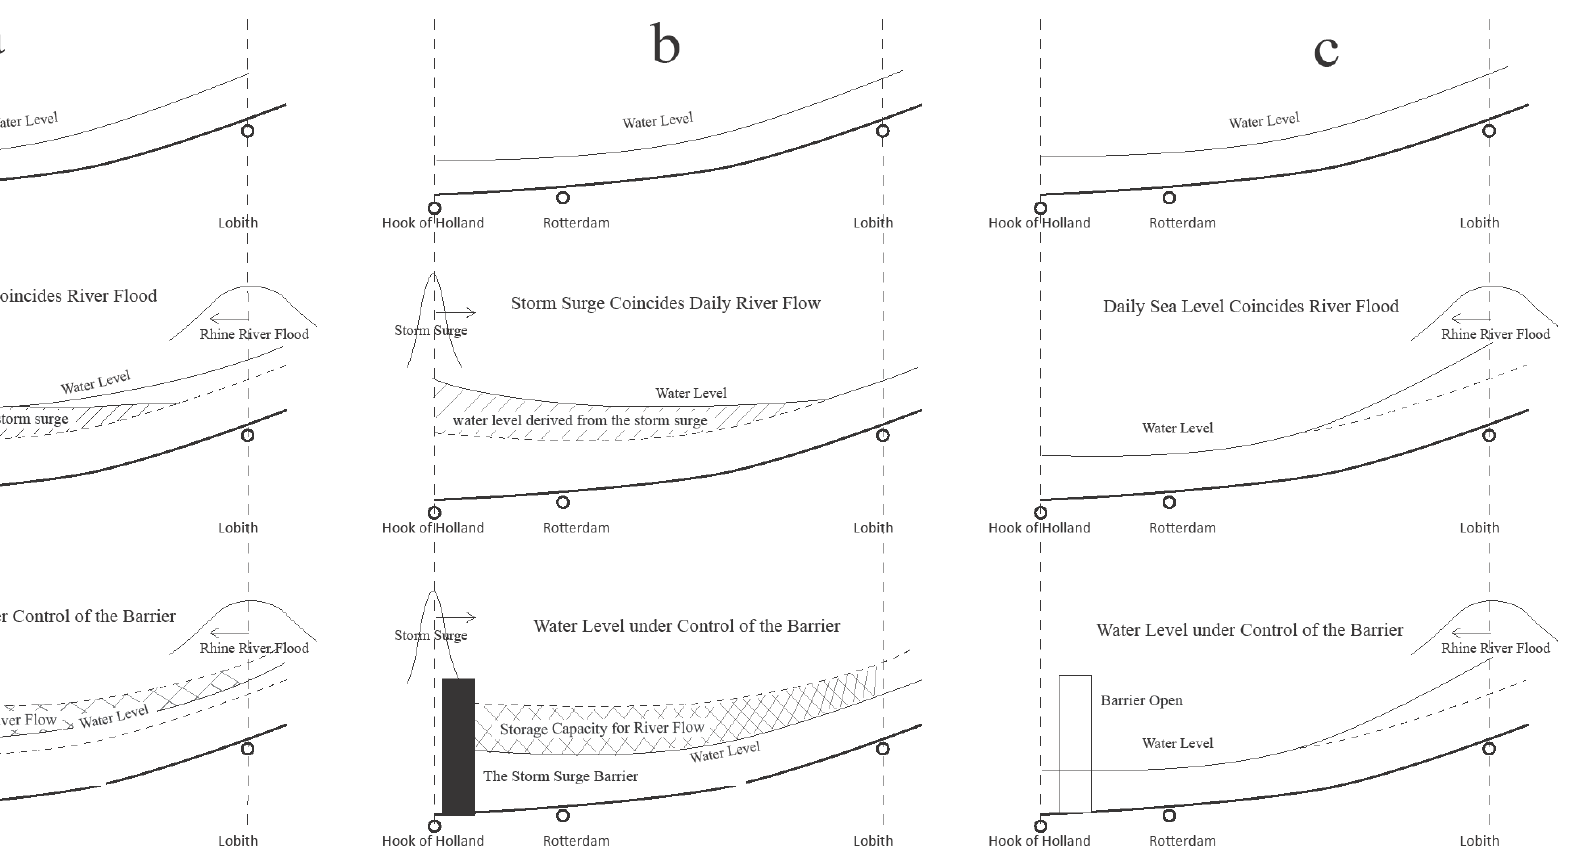
Figure 3. Flooding types and the function of the Maeslant Barrier: ( a ) The surge tide coinciding with Rhine flooding; ( b ) the surge tide coinciding with normal Rhine discharge; ( c ) the normal sea level coinciding with Rhine